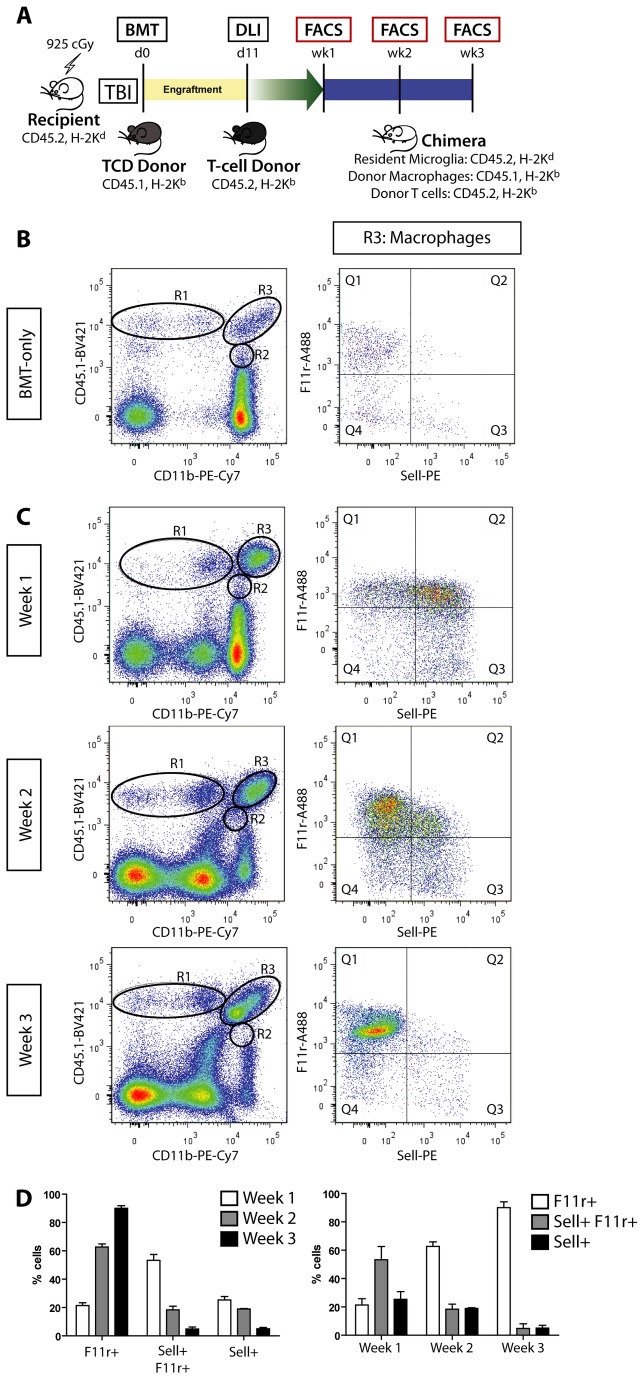
BMDM acquire F11r expression following brain infiltration.(A) GVHD was induced in recipient BALB/cJ mice following total body irradiation (TBI) and bone marrow transplantation (BMT) from T cell depleted (TCD) B6.SJL-Ptprc
a
Pepcb/BoyJ donors. Following C57BL/6J mouse donor lymphocyte infusions (DLI), immune cell infiltration was assessed by flow cytometry at 1 week, 2 weeks, and 3 weeks post-DLI (n=6 GVHD and n=6 BMT-only control per time point). (B) Control BMT-only mice do not exhibit GVHD and lack substantial macrophage (R3) or lymphocyte (R1, and R4 in Figure S4) infiltration. There is a very small CD11b+, CD45.1high monocyte population that expresses F11r in the control brain (<2%; R3, right panel). (C) Chimeric mice with GVHD have donor monocyte infiltration (CD11b+, CD45.1high cells; R3) with negligible CD11b+, CD45.1low cells (R2). F11r and Sell expression (right column) of positively-labeled infiltrating donor monocytes (R3) over the course of 3 weeks of GVHD demonstrates a shift from F11r+ Sell+ cells to F11r+ only cells. (D) Bar graphs illustrate the mean and SEM for each population of immune system cells over the course of the three weeks following DLI.